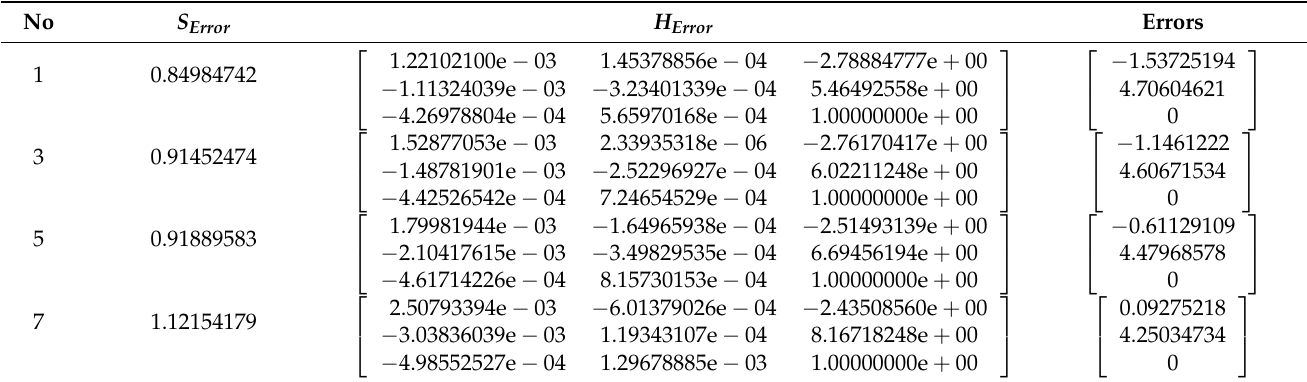
Table 5. Calculation results of error coordinates on horizontal channel.